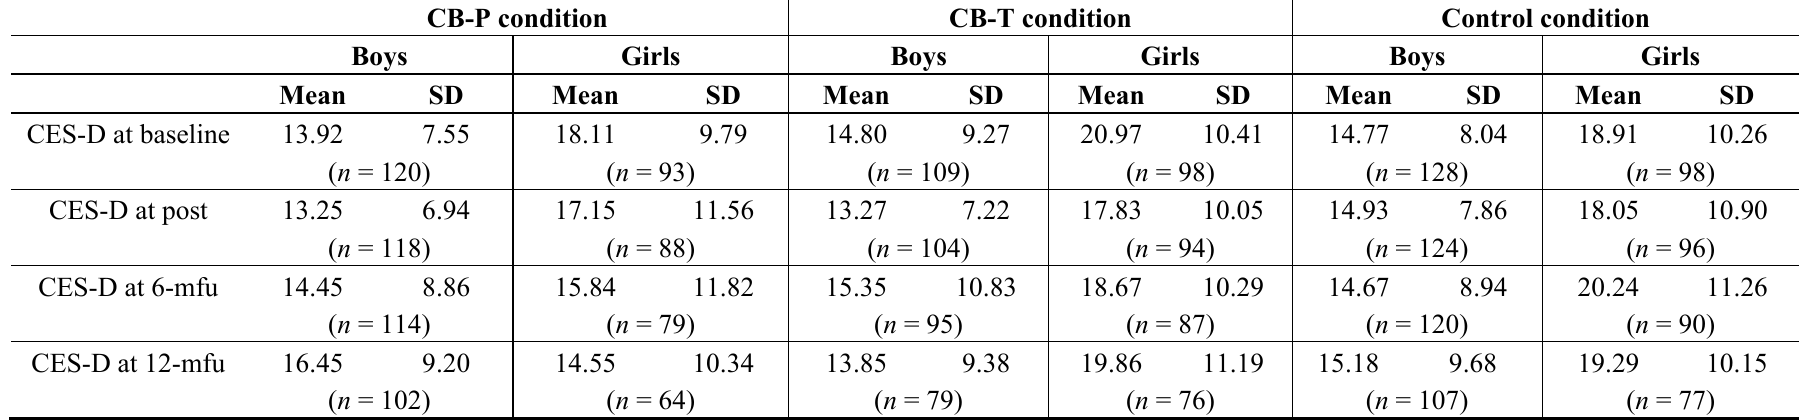
Table 1. Descriptive statistics of depressive symptoms, separated according to gender and measurement times .